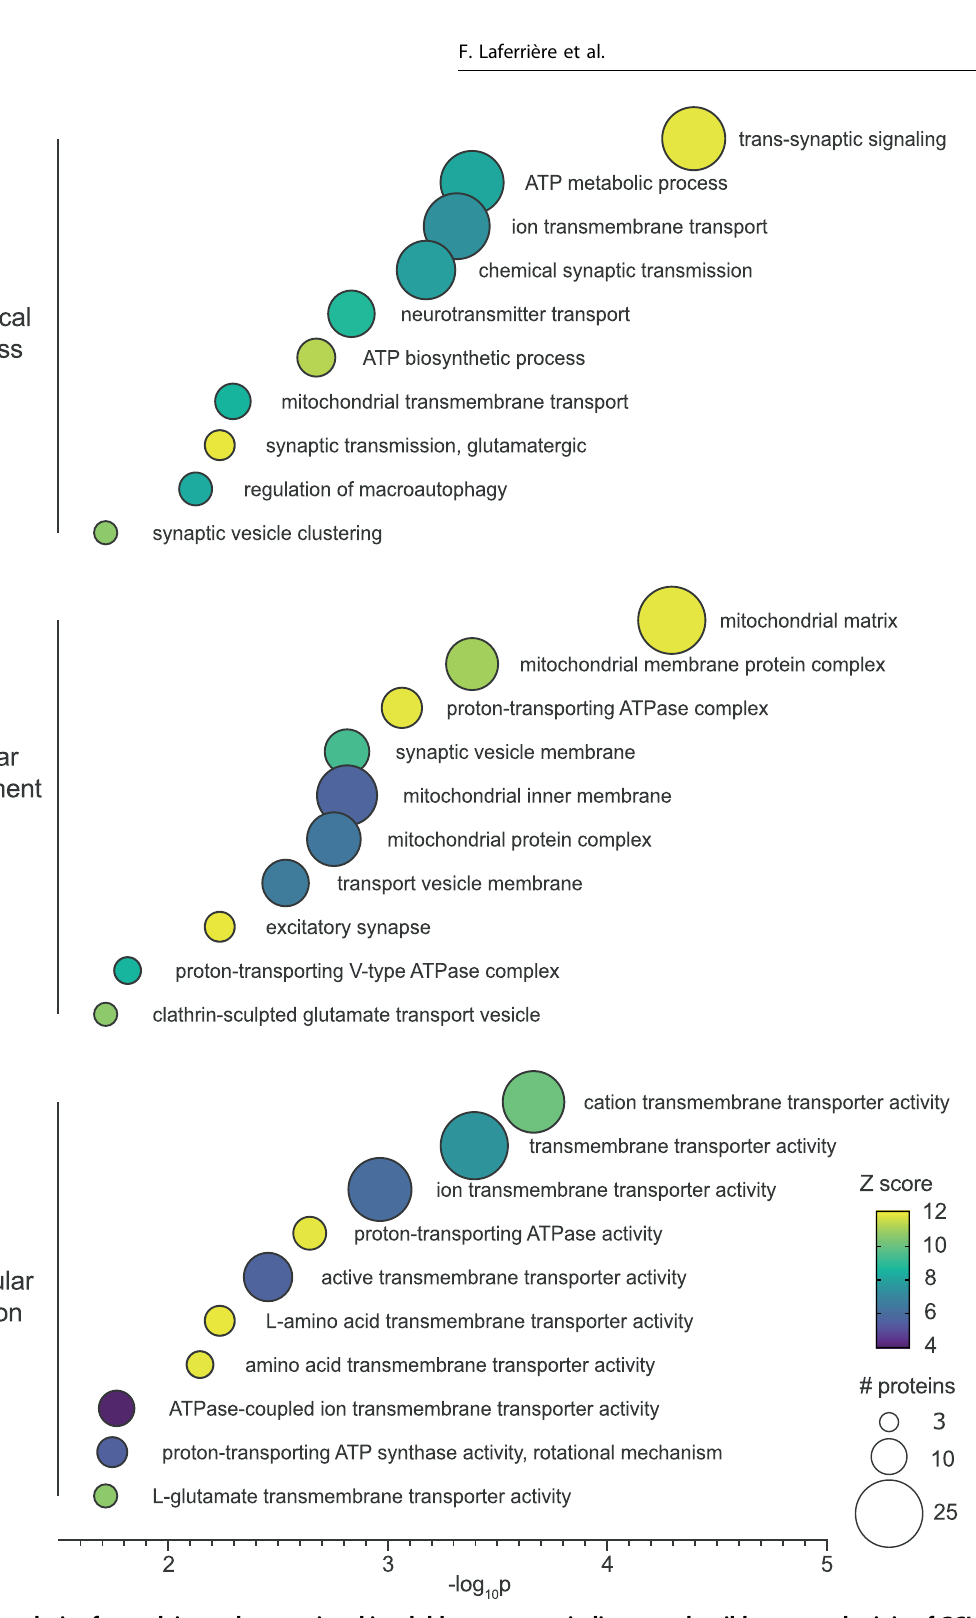
Published in partnership with the Parkinson ’ s Foundation npj Parkinson’s Disease (2022)